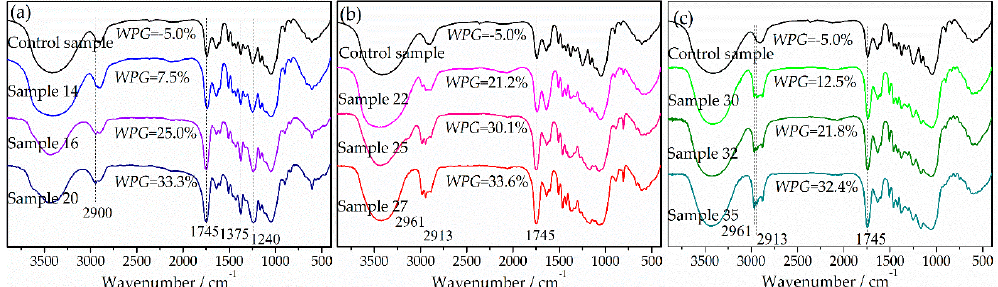
Figure 1. FT-IR spectra of the control sample and SCB acetates ( a ), propionates ( b ) and butyrates ( c ) obtained by the mechanocatalytic esterification. obtained by the mechanocatalytic